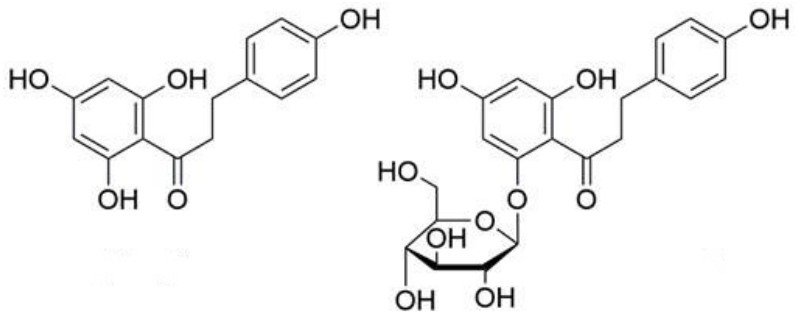
Figure 1. Chemical structure of phloretin and phloridzin.